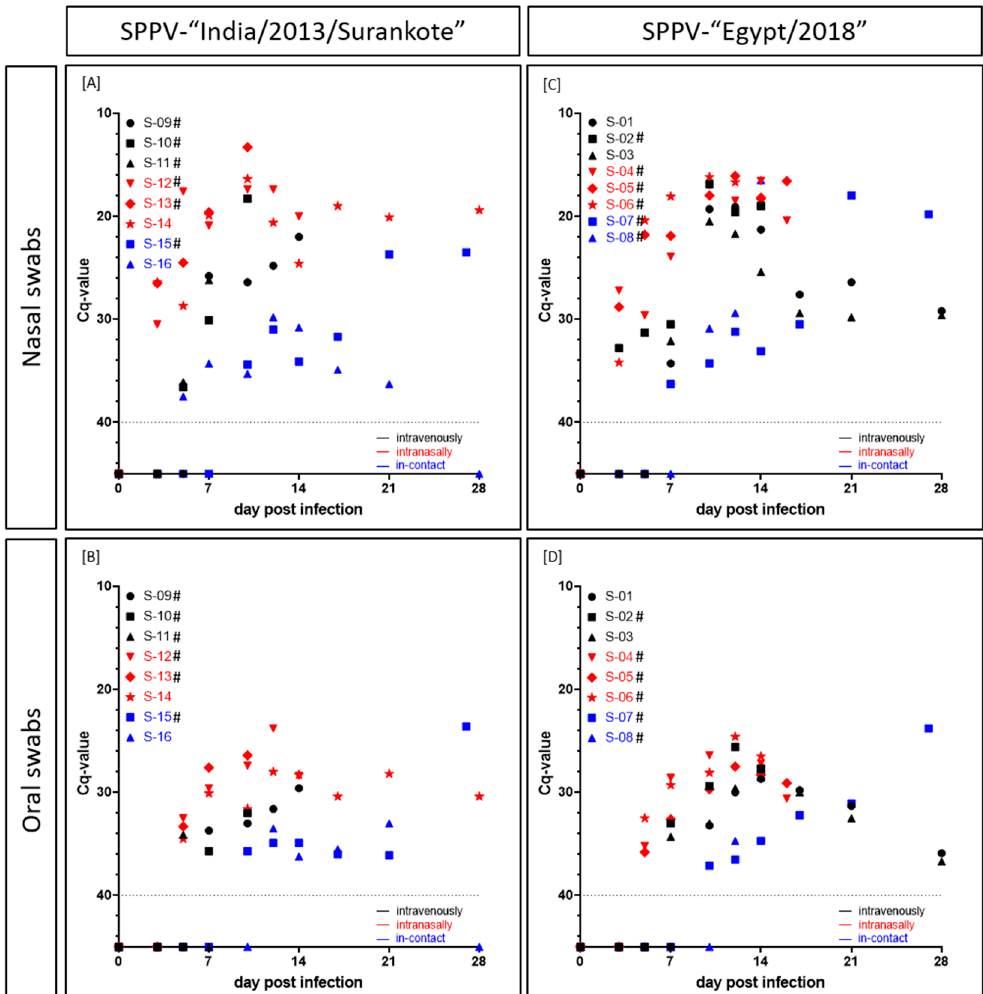
Figure 4. Viral shedding (Cq-values) of sheep experimentally infected with either ( A , B ) SPPV-“India/2013/Surankote” or ( C , D ) SPPV-“Egypt/2018”. ( A , C ) Nasal and ( B , D ) oral swab samples were tested using the pan-capripox real-time qPCR. Thereby, shedding of viral DNA was analyzed. Animals were inoculated via three different routes: intravenous infection (black), intranasal infection (red) and transmission between infected and naïve animals (blue). Cut-off was set at Cq 40.0. # displays animals that were euthanized before the end of the study due to ethical reasons.